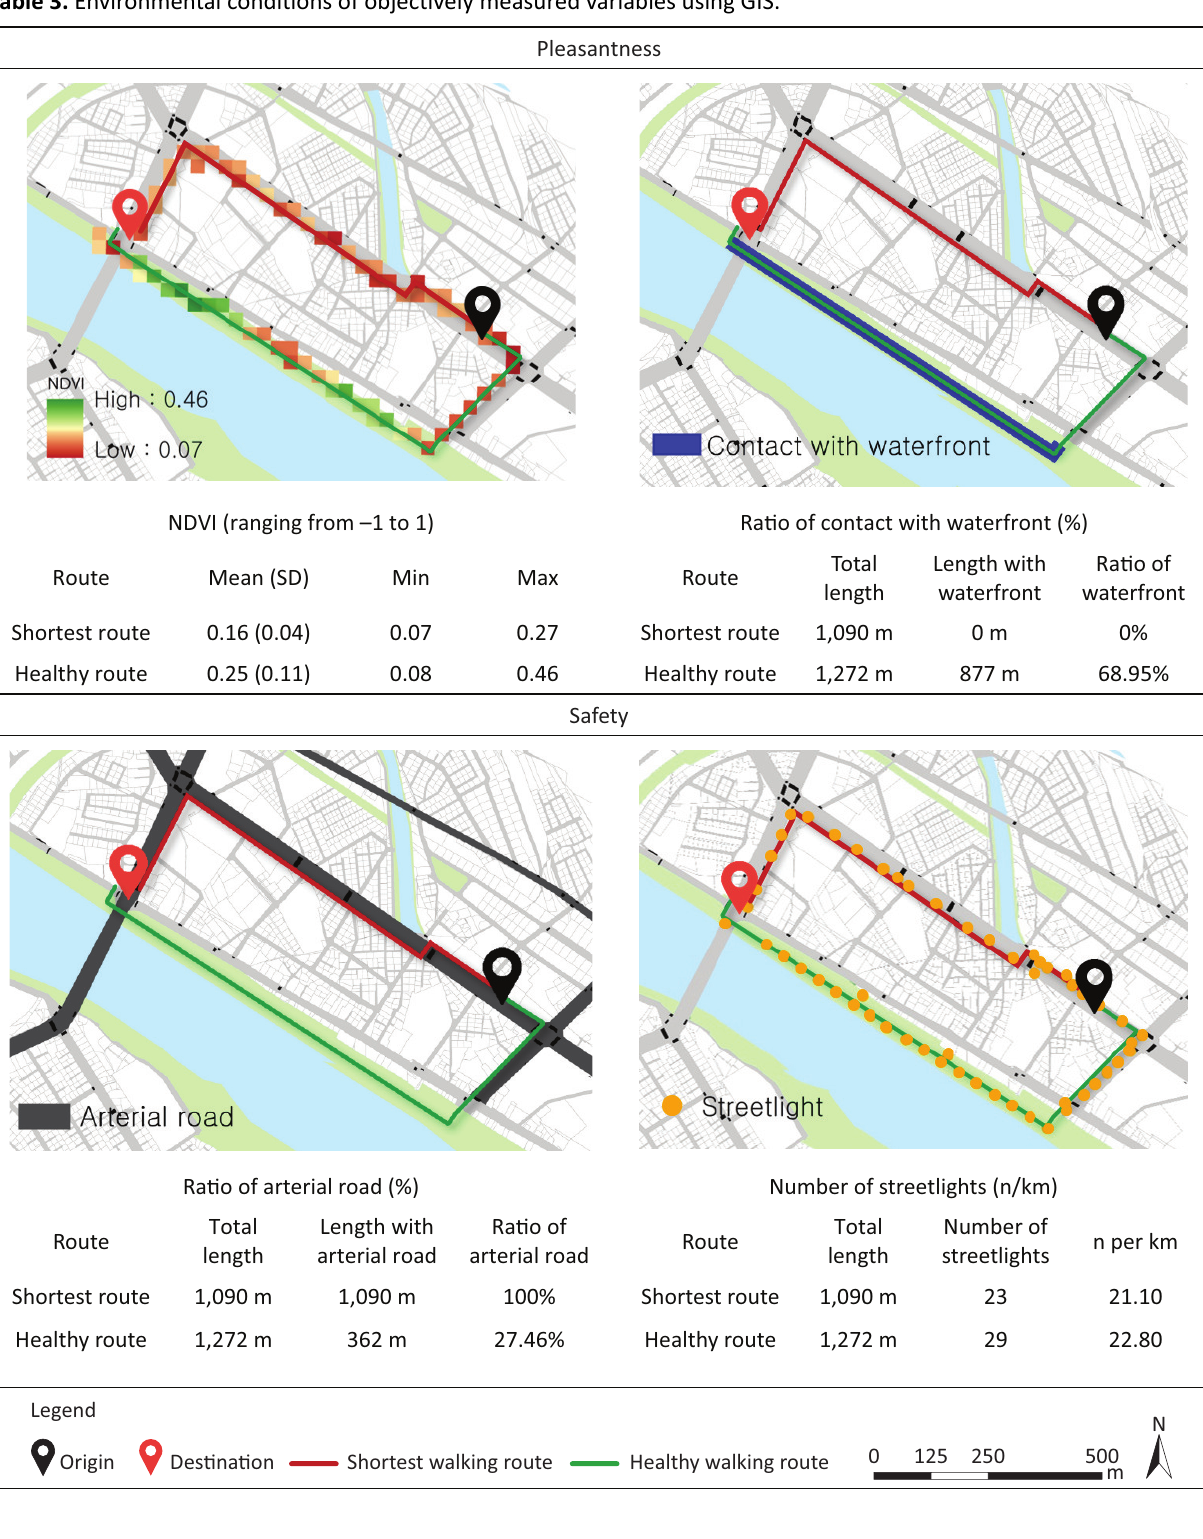
Table 3. Environmental conditions of objectively measured variables using